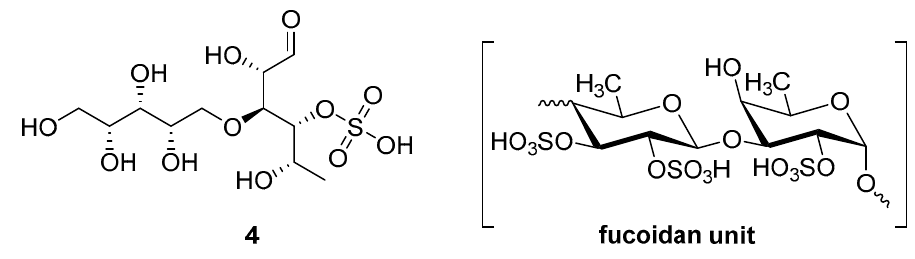
Figure 3. Structure of heparan sulfate ( 3 ).